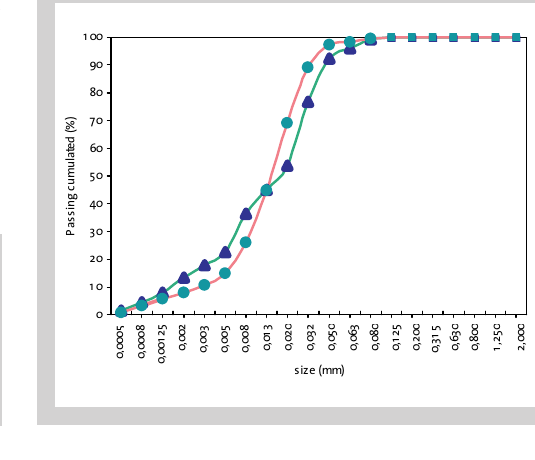
Figure 1: Granular size distribution of the cement grains and the fines.